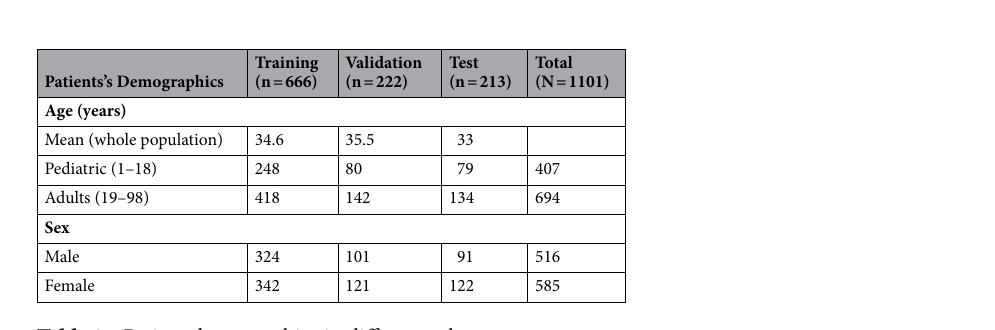
Table 2. Patient demographics in different subsets.